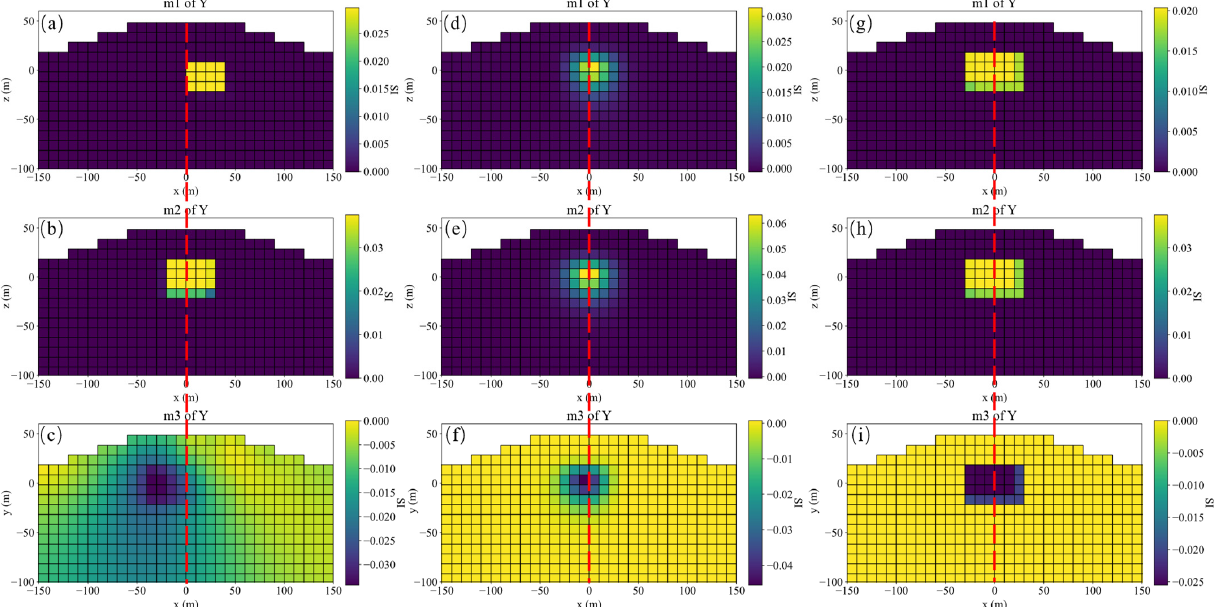
Figure 6. Y slices of the three ‐ component magnetization models inverted by method 1 ( a – c ), method 2 ( d – f ) and method 3 ( g – i ), respectively.